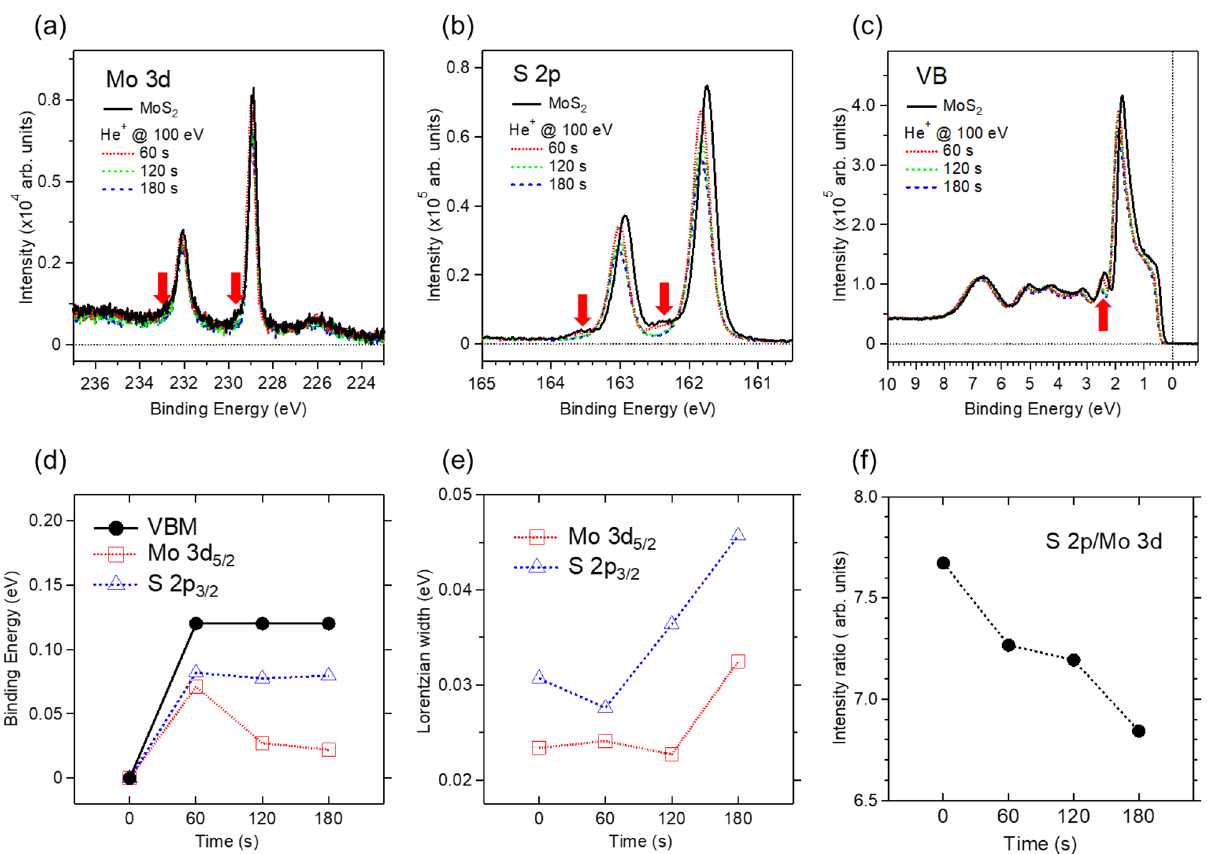
Figure 3. ( a – c ) Comparison of Mo 3 d , S 2 p , and valence-band photoemission spectra obtained by in-situ He + ion irradiation on the freshly cleaved surface of the MoS 2 single crystal. These spectra were taken at the photon energies of hν = 300 eV, 222 eV, and 56 eV, respectively. The red arrows beside the prominent p-type peaks indicate the n-type features (see the context for details). ( d ) The binding energy shifts of the prominent Mo 3 d 5/2 and S 2 p 3/2 peaks and the VBM. The binding energies of the cleaved MoS 2 surface are 228.92 eV, 161.74 eV, and 0.30 eV, respectively. ( f ) Comparison of Lorentzian linewidth of Mo 3 d and S 2 p core-level spectra. ( g ) The intensity ratio of the S 2 p to Mo 3 d core-level